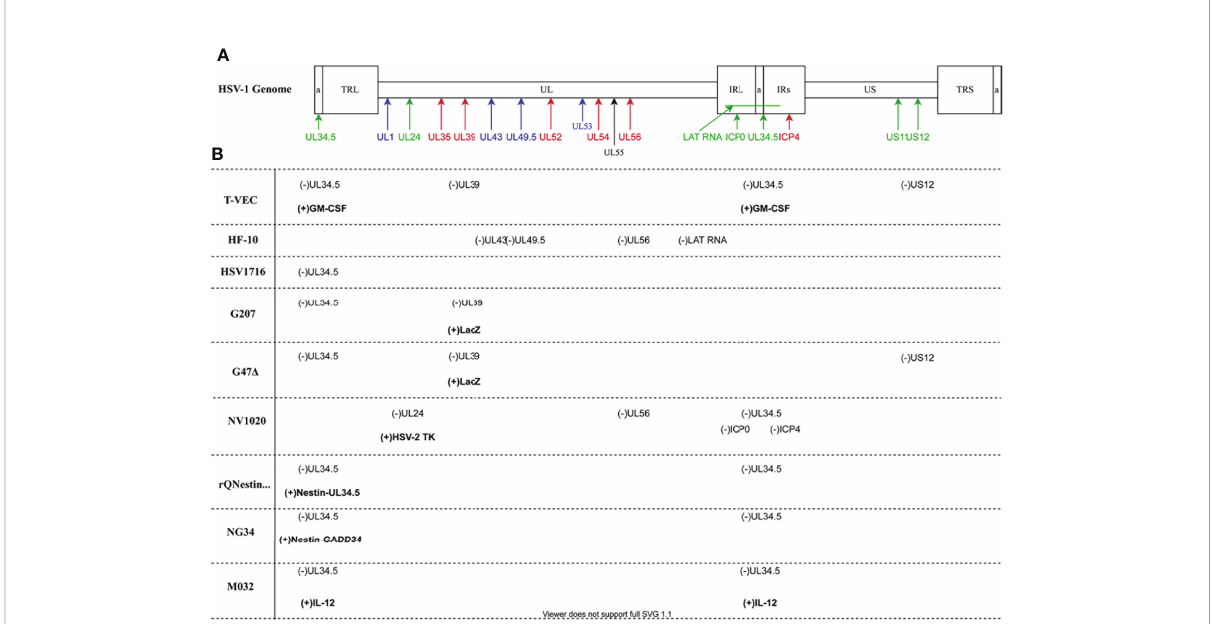
FIGURE 2 HSV-1 Genomic map and oncolytic virus modi fi cations (A) The HSV-1 genome has two covalently joined segments long (L) and short (S) each of which has a unique sequence (U L and U S ) fl anked by a pair of repeat sequences, the terminal and internal long repeats (TL L , IR L , TR S and IR S ). There is also a 400 base pair terminal repeat at each end of the genome and internally at the joint between the L and S segments which is called ( a ) Genes are coded according to functional group: blue- structural; red- replication; green- virulence. (B) Oncolytic viruses mentioned in the paper. Deleted viral genes are indicated as (-) while transgenes or viral genes that have been inserted are in bold and indicated by (+). Diagram prepared with